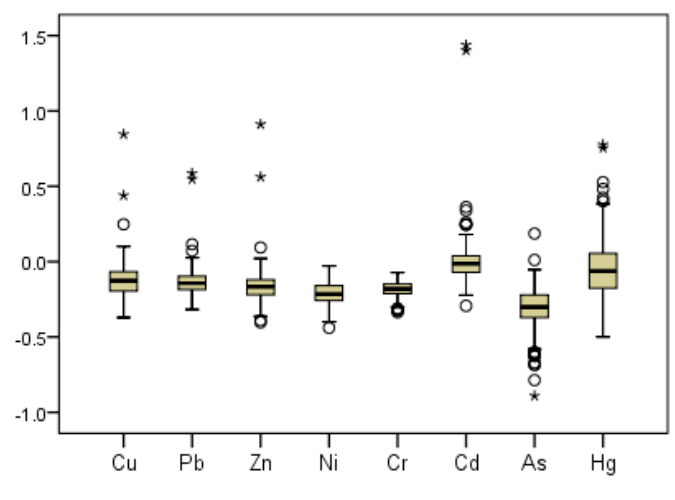
Figure 2. Box plots of metal(loid) Igeo values.